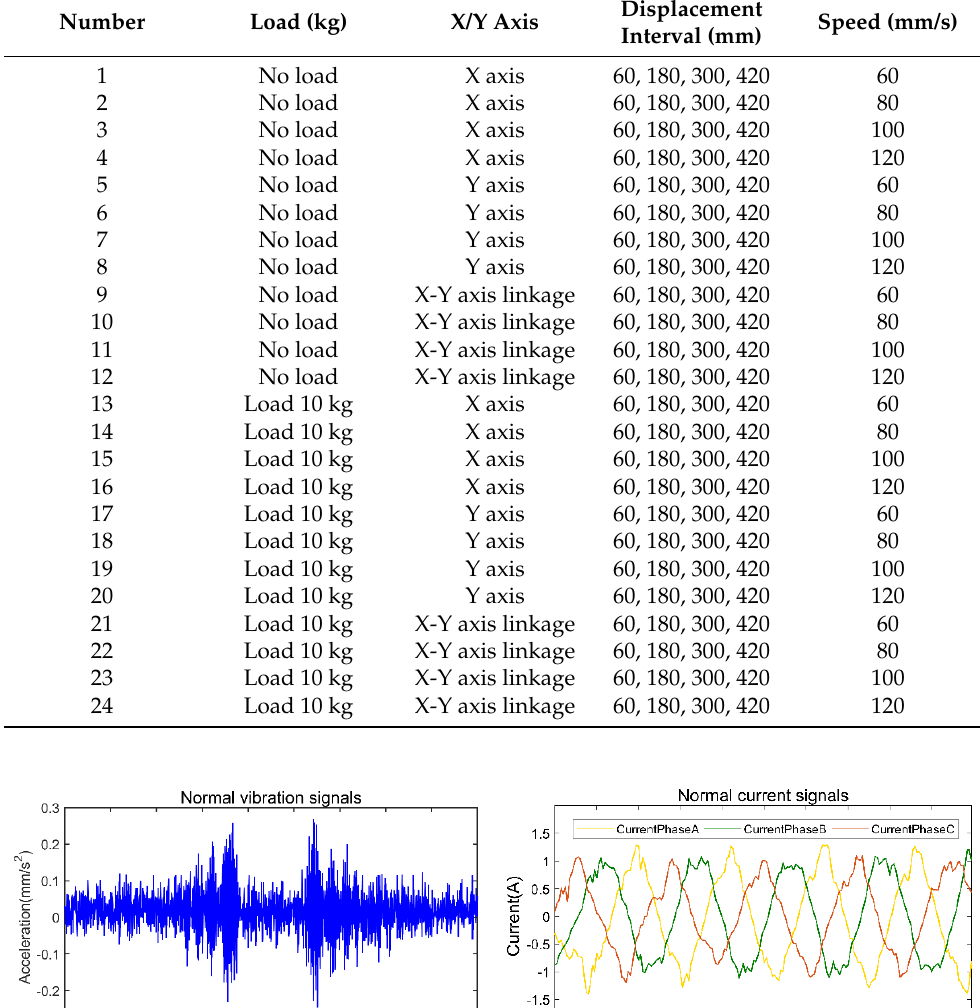
Table 3. Experimental working condition settings.